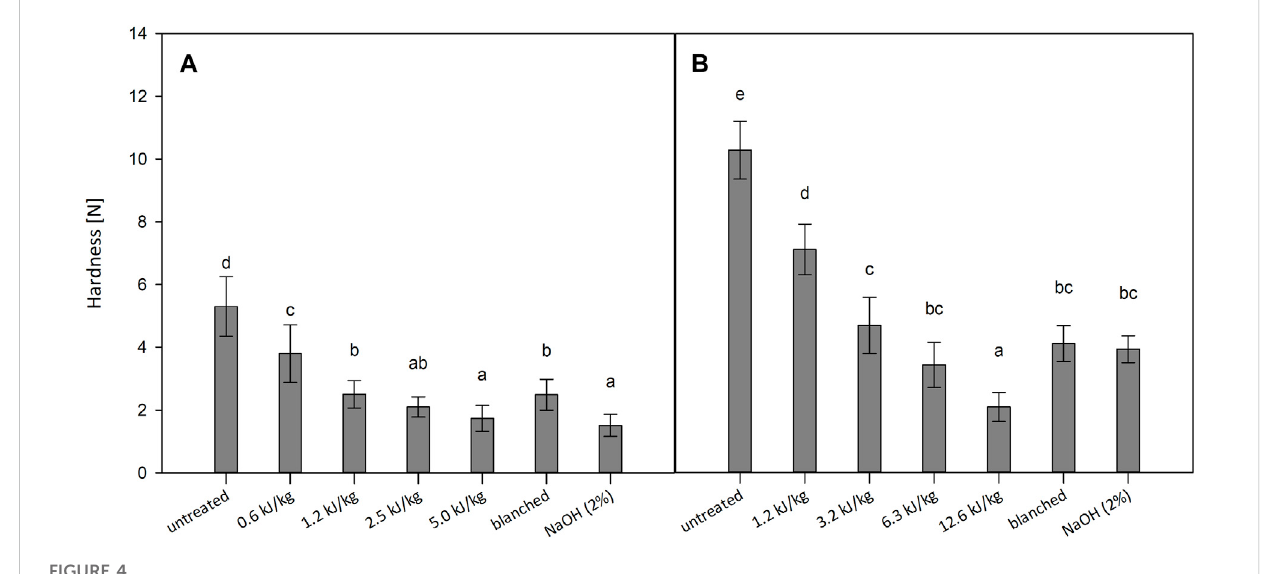
FIGURE 4 Hardnessvaluesforuntreated,PEFtreated,blanchedandlyepeeledtomatoes (A) andkiwifruits (B) .Signi fi cantdifferencesareindicatedbydifferent letters ( p < 0.05).